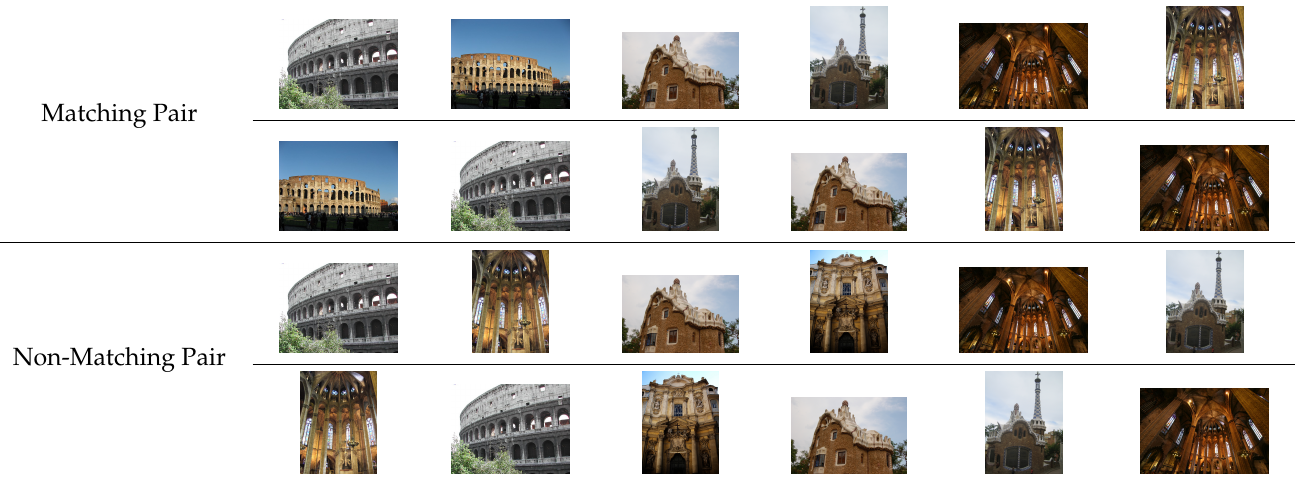
Table 1. Examples of matching/non-matching